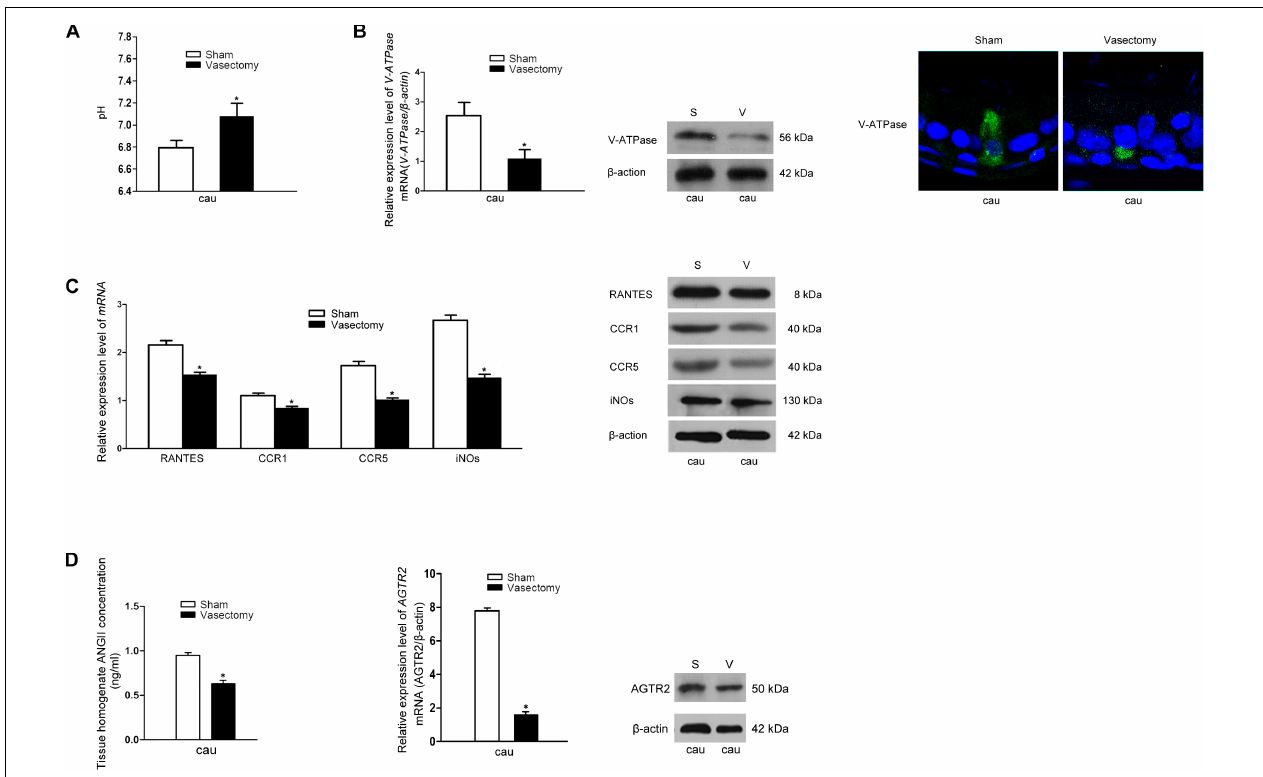
FIGURE 5 | Effects of rat vasectomy on the luminal pH and the expression of V-ATPase, RANTES, CCR1, CCR5, iNOS, and RAS. (A) 8 weeks after rat bilateral vasectomy, luminal fluid pH of cauda epididymis increased and remained alkaline. (B) The expression of V-ATPase in rat cauda epididymis was detected by Real time-PCR, WB and IF staining. (C) 8 weeks after rat bilateral vasectomy, the expression levels of RANTES, CCR1, CCR5, and iNOS mRNA and protein in cauda epididymis were decreased revealed by Real time-PCR and WB. (D) The tissue homogenate ANG II concentration were measured by RIA and the expression of AGTR2 was detected by Real time -PCR and WB. * P < 0.05, N = 5–6, Bar = 20 µ